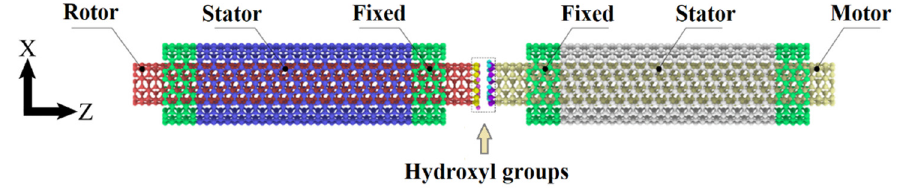
Figure 1. Illustration of the transmission system consisting of two